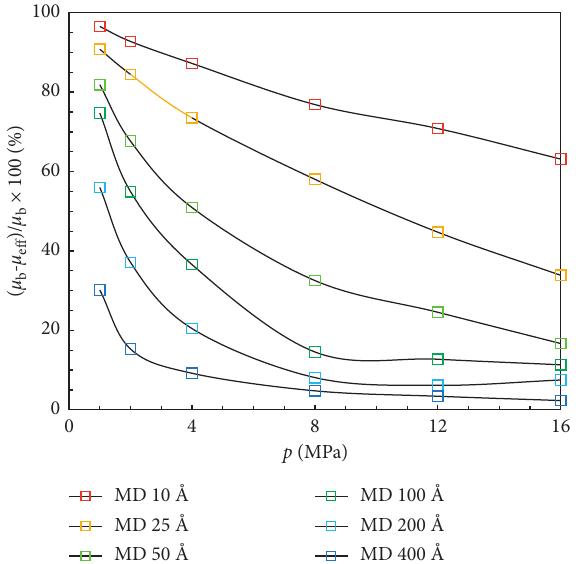
Figure 6: The gas viscosity changes rate in the slit pore with pressure for different width pores at 343.15 K (the symbols denote the viscosity of methane in organic slit nanopore. Lines are drawn as a guide to the